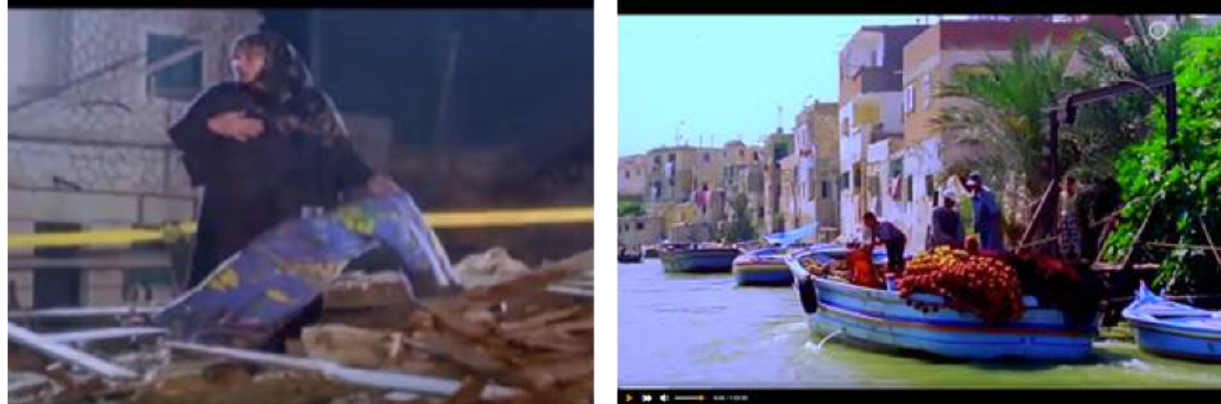
Figure 6. Still shots from Bolteya El‐Ayma . Notes: On the left, the main character is standing on the ruins of her demolished house; on the right, it’s a depiction of daily life using the